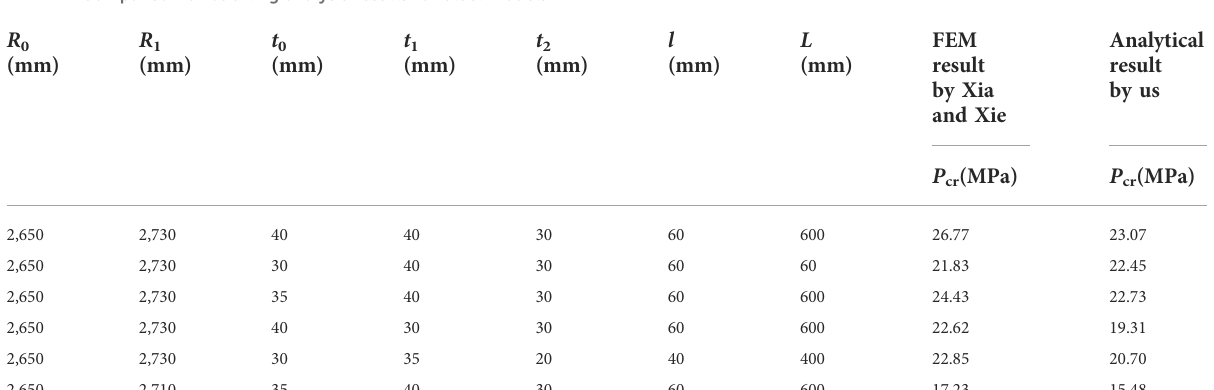
TABLE 4 Comparison of buckling analysis results for steel